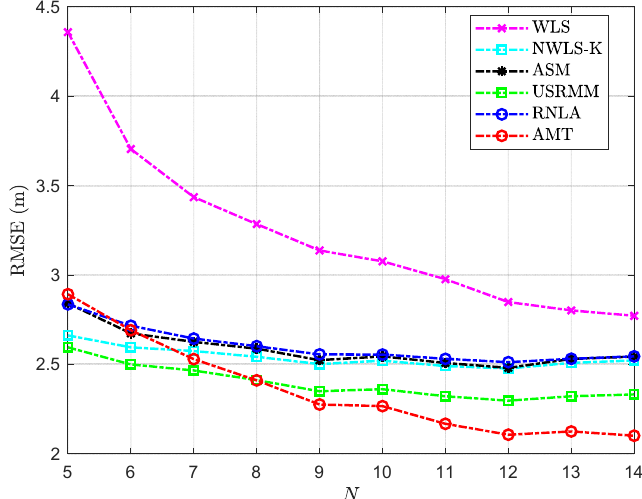
= 4 dB, α = 0.06 dB/m, and the side f i